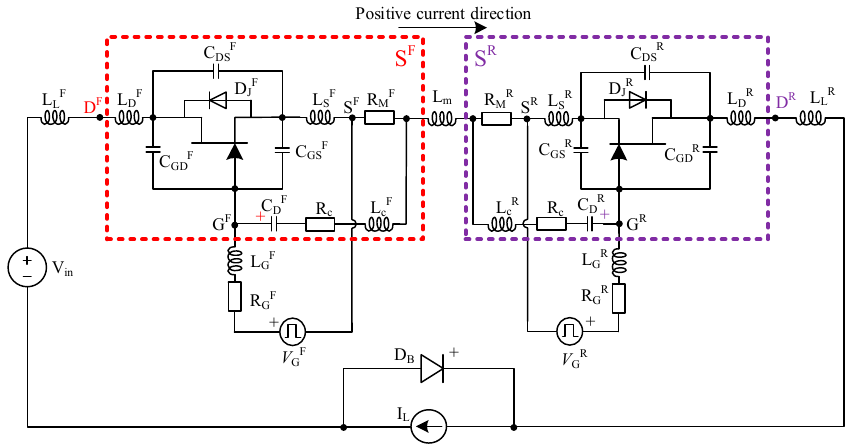
Figure 2. The transient circuit schematic diagram of the double-pulse test circuit of SiC JFET-based BDSs.